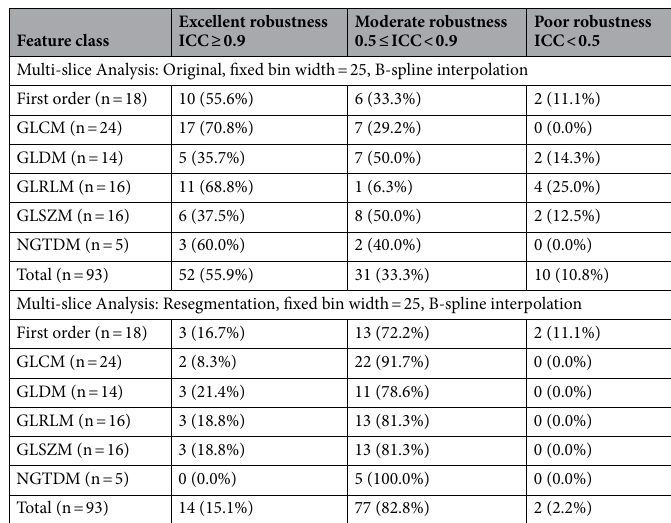
Table 2. Number of radiomic features with excellent, moderate and poor robustness by feature class in multi- slice analysis. Definition of ICC used = 2-way mixed-effects model, absolute agreement, single rater intraclass correlation coefficient; n, number of radiomics